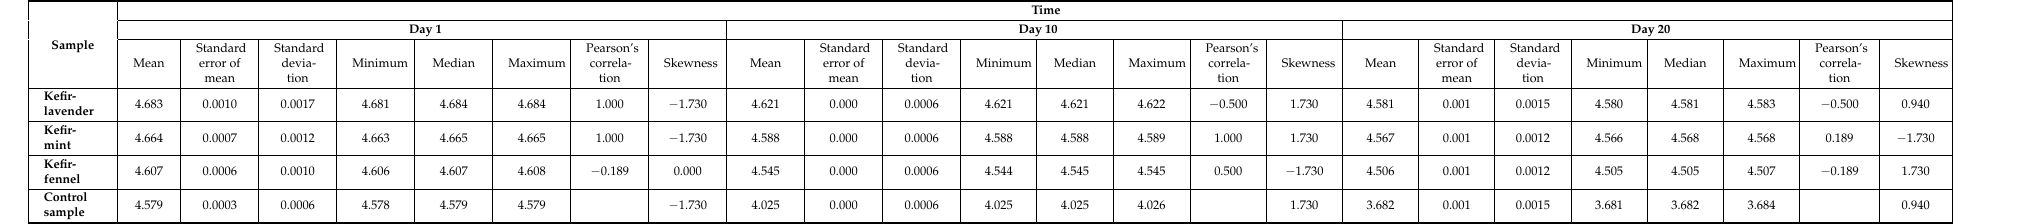
Table A1. Determination of lactose content.